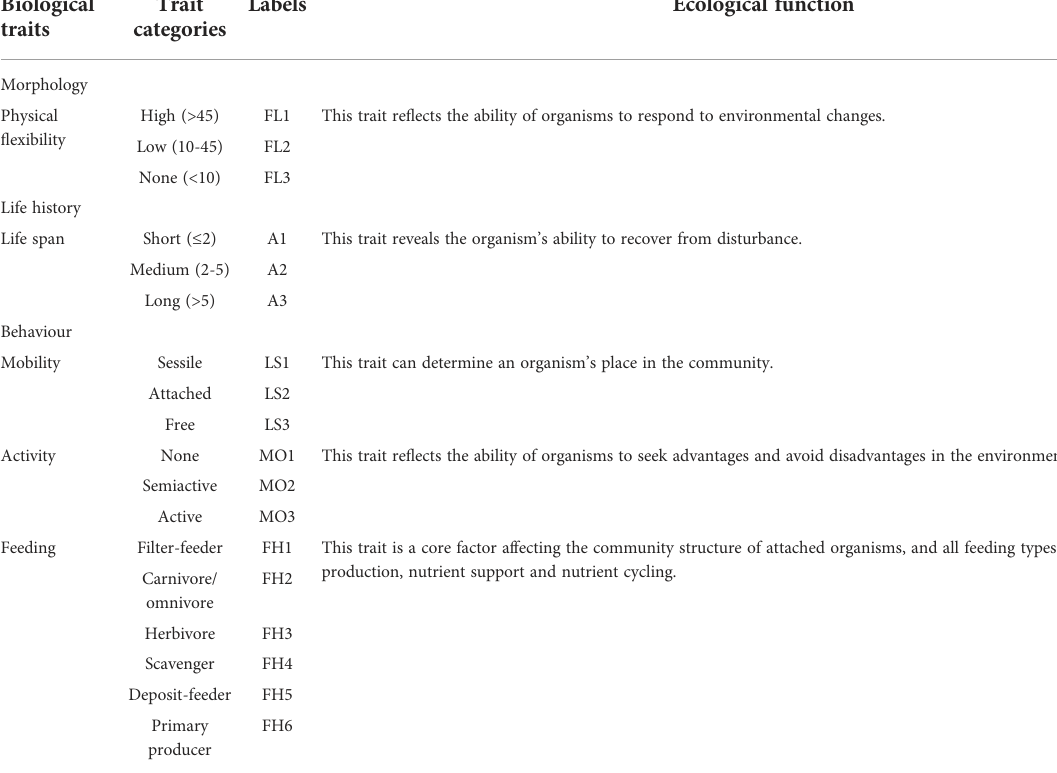
TABLE 1 The biological characteristics and morphology of attached